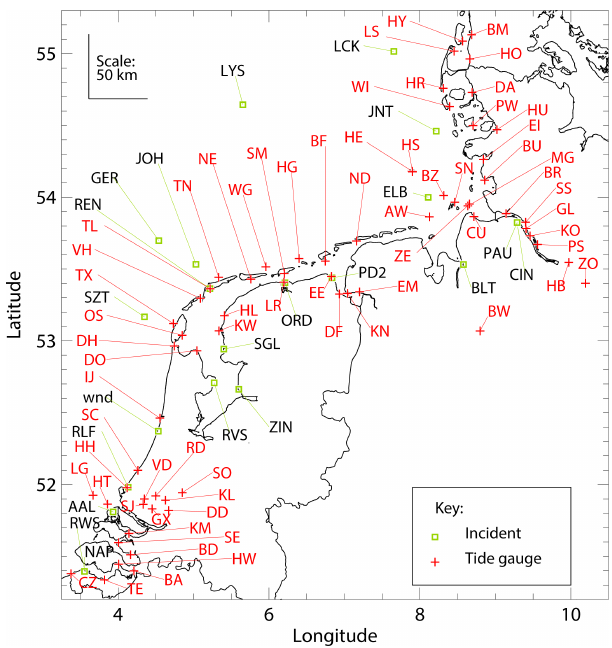
Figure 3. Location of tide gauges and maritime incidents along the North Sea coasts of the Netherlands, Germany, and southern Den- mark. The abbreviation codes for the tide gauges and maritime in- cidents are explained in Tables S2 and S3.